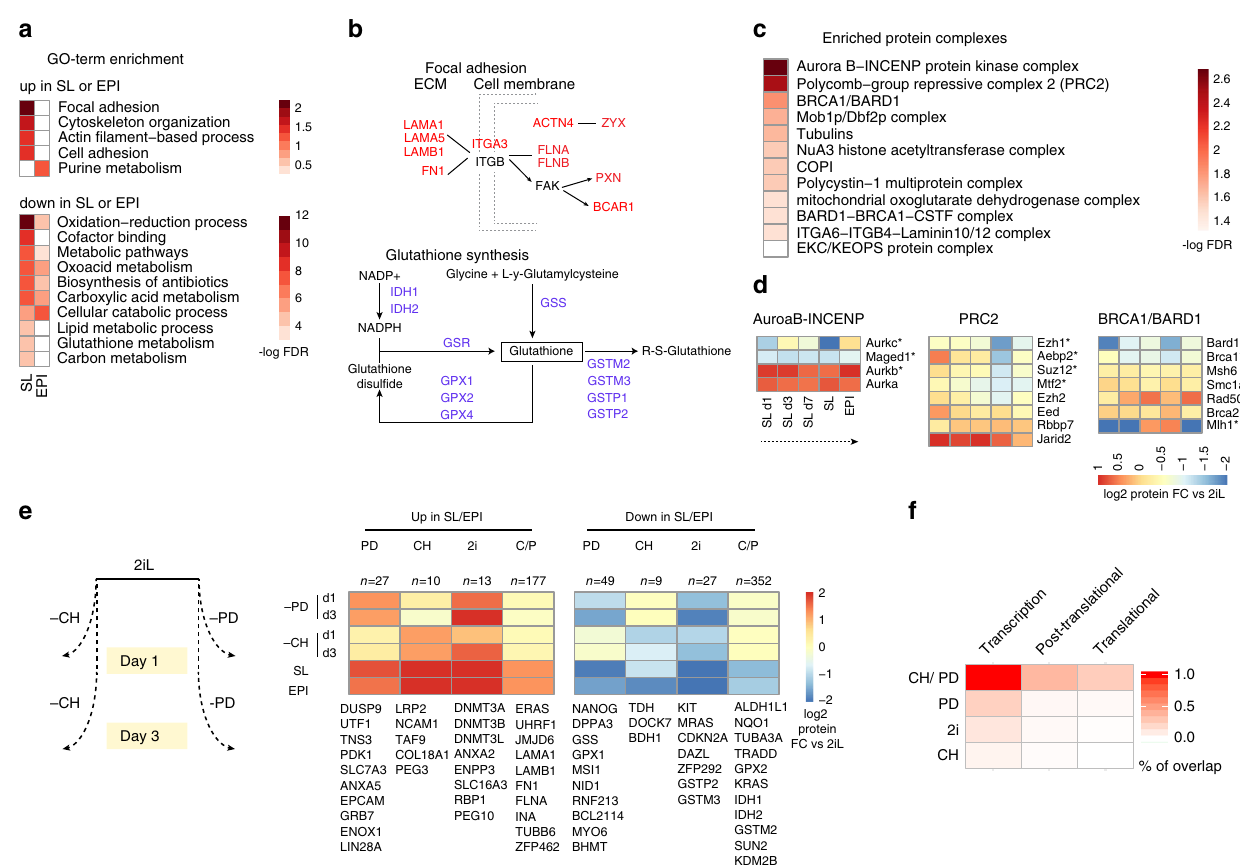
Fig. 5 Functional annotation of differentially expressed proteins in different states of pluripotency. a Gene ontology analysis of differentially expressed proteins in SL or EPI when compared to 2iL state. Two-sided P values were adjusted for multiple testing using Benjamin – Hochberg correction. b Examples of GO-term categories enriched in SL (focal adhesion) or in 2iL (glutathione metabolism). Differentially expressed proteins belonging to each category are shown. Upregulated proteins in SL or EPI are shown in red and upregulated proteins in 2iL are shown in blue. c Enrichment analysis for large protein complexes using differentially expressed genes between 2iL and SL/EPI. Two-sided P values are derived from the hypergeometric test associated with each protein complex and were adjusted for multiple testing using Benjamin – Hochberg correction. d Heat-map showing the fold change in protein expression for members of the top three enriched protein complexes from panel c and during 2iL to SL and EPI transition. e Single inhibitor withdrawal proteomics. 2iL cells were cultured for 1 and 3 days with serum-free medium supplemented with CH/LIF or PD/LIF and were employed in proteome analysis. Heat-map showing the change in protein expression for the 642 differentially expressed proteins between SL/EPI and 2iL. “ C/P ” refers to the proteins that require either PD or CH to maintain expression similar to 2iL ESCs; only removing both inhibitors from 2iL induces changes resembling the SL/EPI states. “ 2i ” refers to the proteins that require both PD and CH signaling to maintain expression similar to 2iL state; removing either PD or CH from 2iL induces changes similar to SL/EPI state. “ P ” refers to the proteins that require PD to maintain an expression pattern similar to 2iL. “ C ” refers to the proteins that require CH to maintain an expression pattern similar to 2iL. n = 642 differentially expressed proteins. f The overlap between differentially expressed proteins regulated at the three levels and downstream of PD or CH single